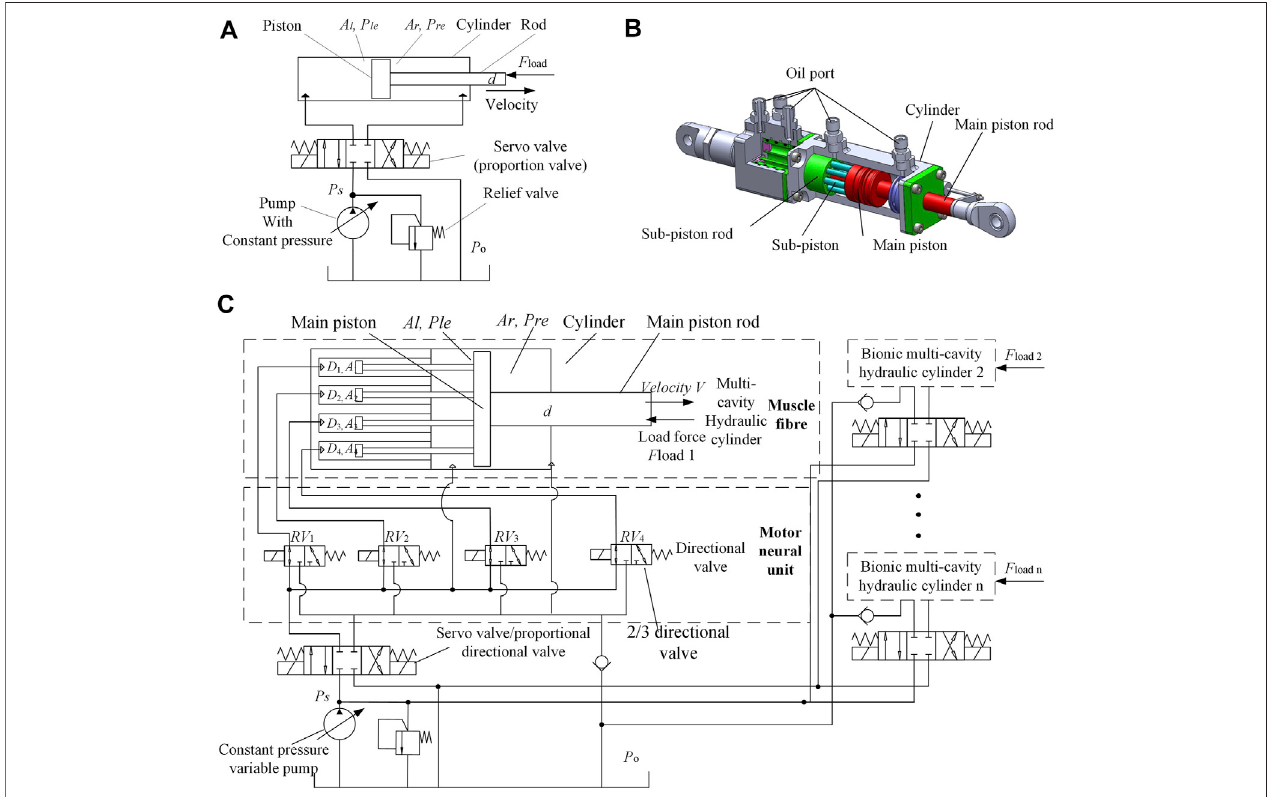
FIGURE 4 | Design of a New Biomimetic Hydraulic Actuator (A) . Hydraulic actuator system with typical cylinder; (B) . Multi-chamber hydraulic actuator structure; (C) . Hydraulic system structure based on the bionic hydraulic actuator.